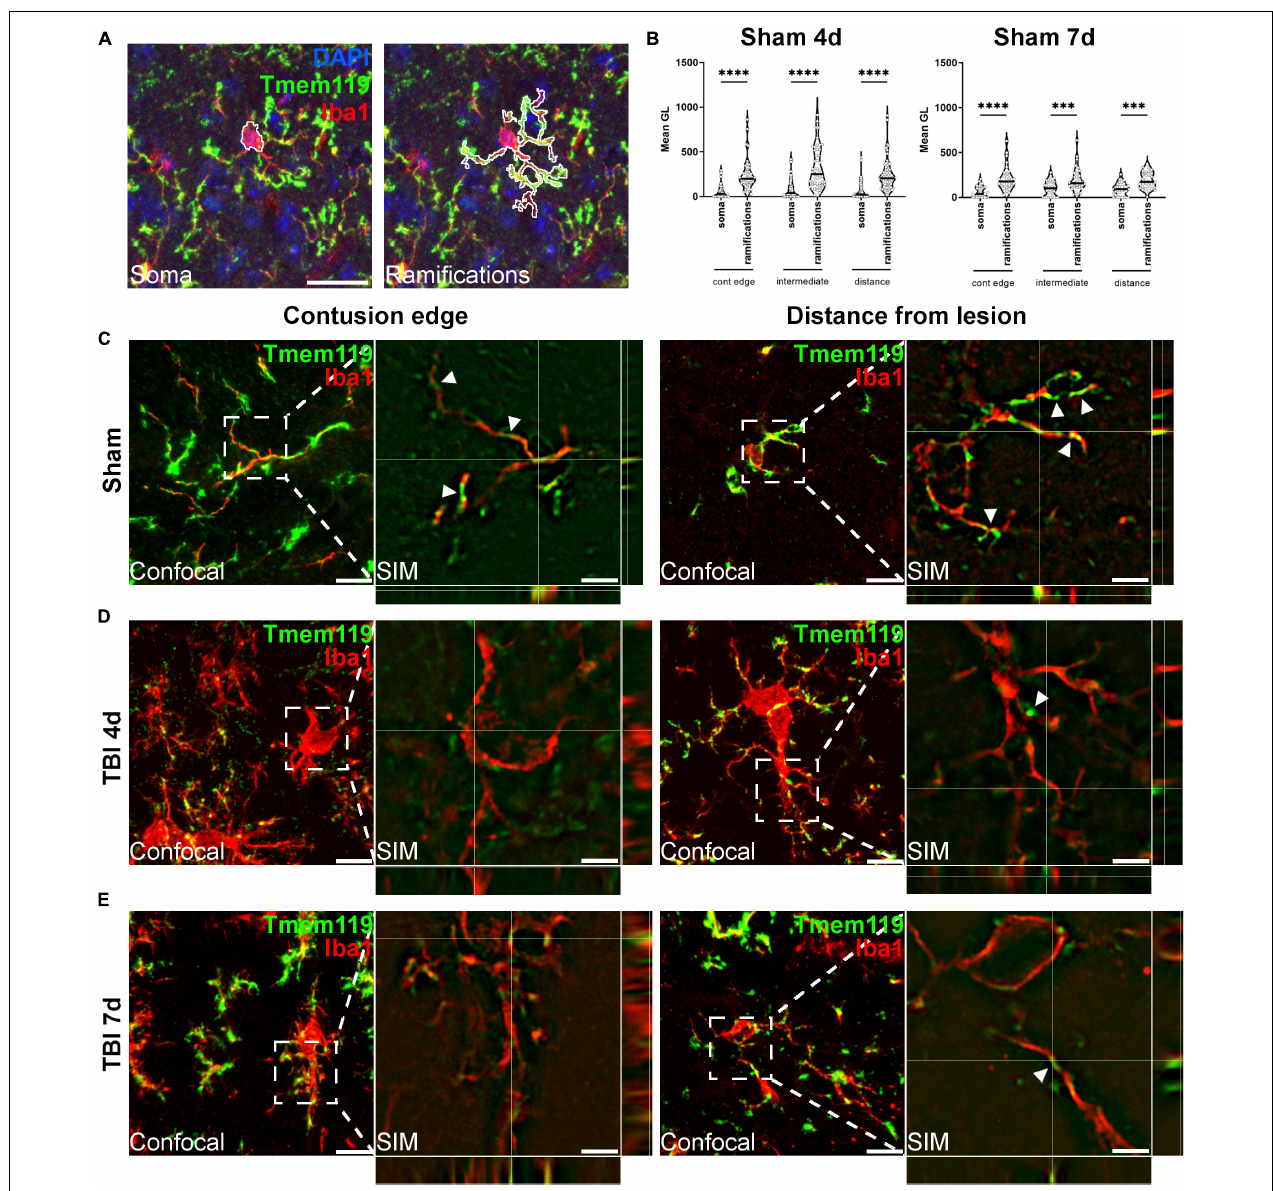
FIGURE 5 | Subcellular localization of Tmem119. (A) Outline tracing for the differential analysis of Tmem119 in soma vs. ramifications of Iba1+ cells. Scale bar 20 µ m. (B) Tmem119 immunoreactivity was higher in ramifications compared to the soma of Iba1+ cells at 4 and 7 days after sham surgery. Data are shown as violin plot with single replicates (cells), line at median and quartiles, n = 92–155 cells from three mice per group. Two-way ANOVA followed by Sidak’s multiple comparison test, ∗∗∗ p < 0.001, ∗∗∗∗ p < 0.0001. (C) We analyzed the subcellular localization of Tmem119 by super-resolved SIM. Tmem119 (green) appeared to be predominantly located on Iba1+ cell (red) ramifications, as clearly seen on the highly ramified cells present in sham mice. (D,E) In the contused cortex, at either 4 (D) and 7 (E) days after TBI, Tmem119 was still visible on myeloid cells ramifications of hypertrophic Iba1+ cells. Scale bars 10 µ m in confocal images, 2 µ m in SIM images. SIM images present z-stack orthogonal views and arrowheads indicating a few Tmem119 positive